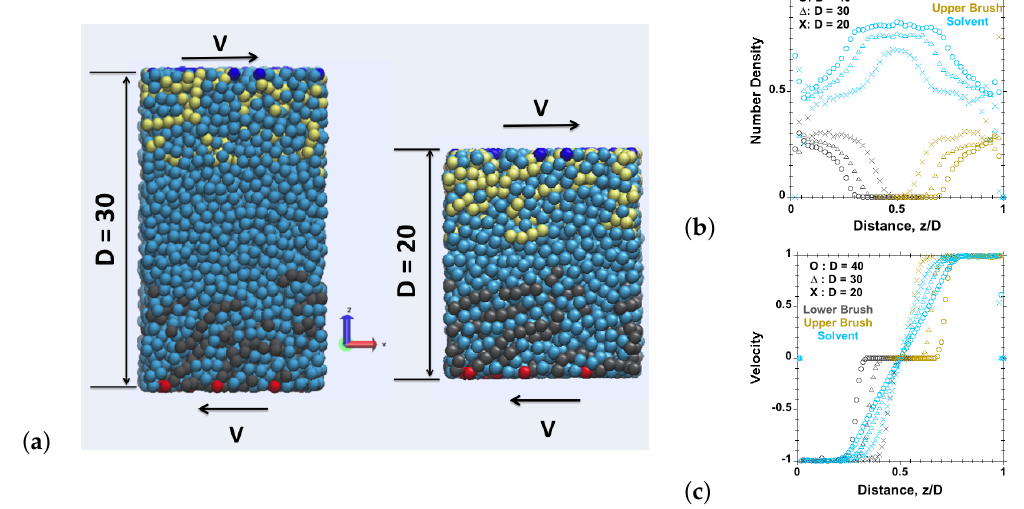
Figure 1. Representative information from a brush-against-brush system with explicit solvent, subjected to shear. ( a ) Snapshots, where polymer beads are colored by black (bottom) and yellow (top), tethered beads colored by red (bottom) and blue (top) and solvent beads colored by cyan; ( b ) number density profiles and ( c ) velocity profiles versus distance to the bottom surface ( M = 20 chains tethered on each surface, N = 30 beads per chain, surface-tethering density ρ = 0.075, at velocity v = 1 applied on tethered beads on both sides in opposite directions at separation D = 50). All dimensional quantities are given in Lennard–Jones (LJ) units. These particular sets of simulations were performed at very high shear velocity, v = 1, to achieve a visible amount of alignment, whereas the shear velocity of all subsequent simulations does not exceed v =